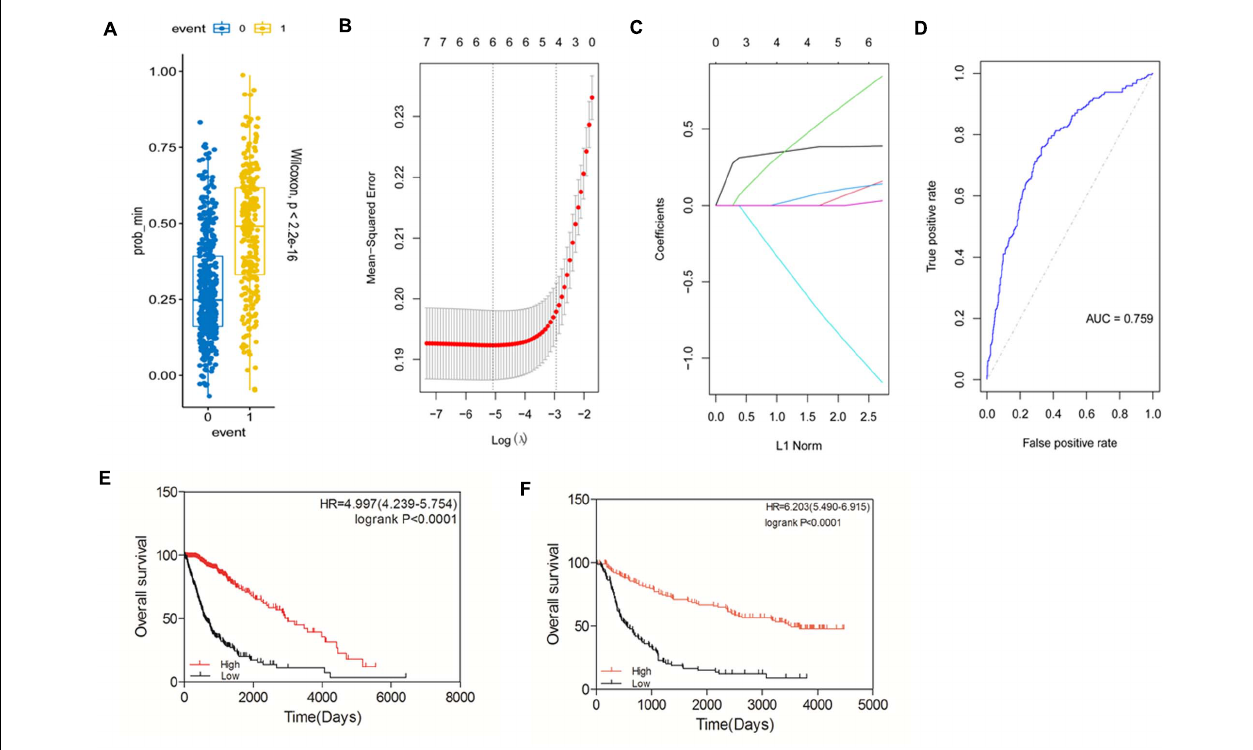
FIGURE 6 | Construction of a prognostic gene signature model based on the STAT gene family. ( A–D) Construction of a new prognostic signature. (E) Prognostic value of the new signature in glioma using TCGA database. (F) Prognostic value of the new signature in glioma using CGGA